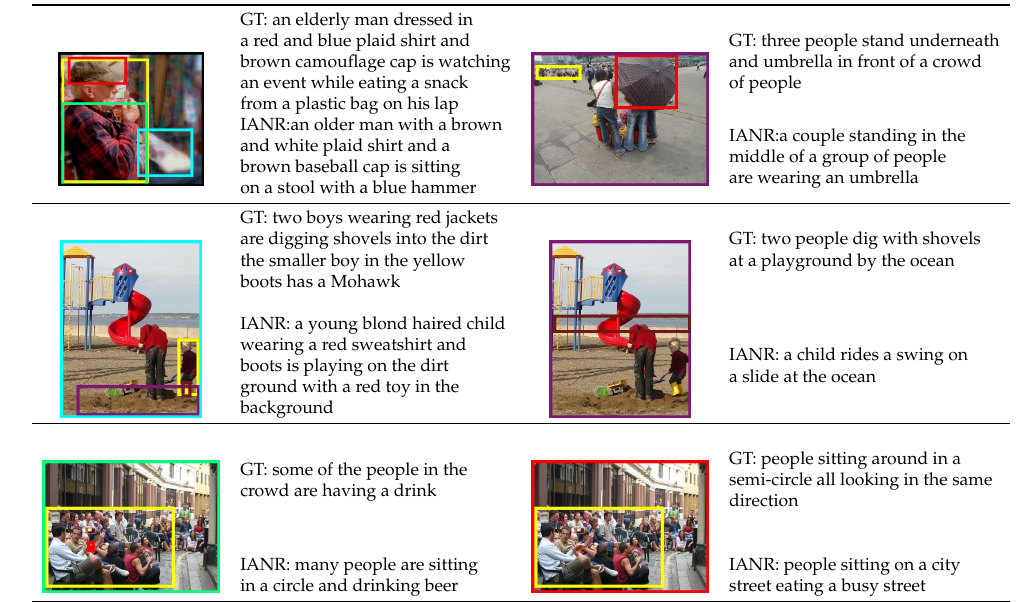
Figure 4. Examples of ground truth and a failed case generated by the proposed